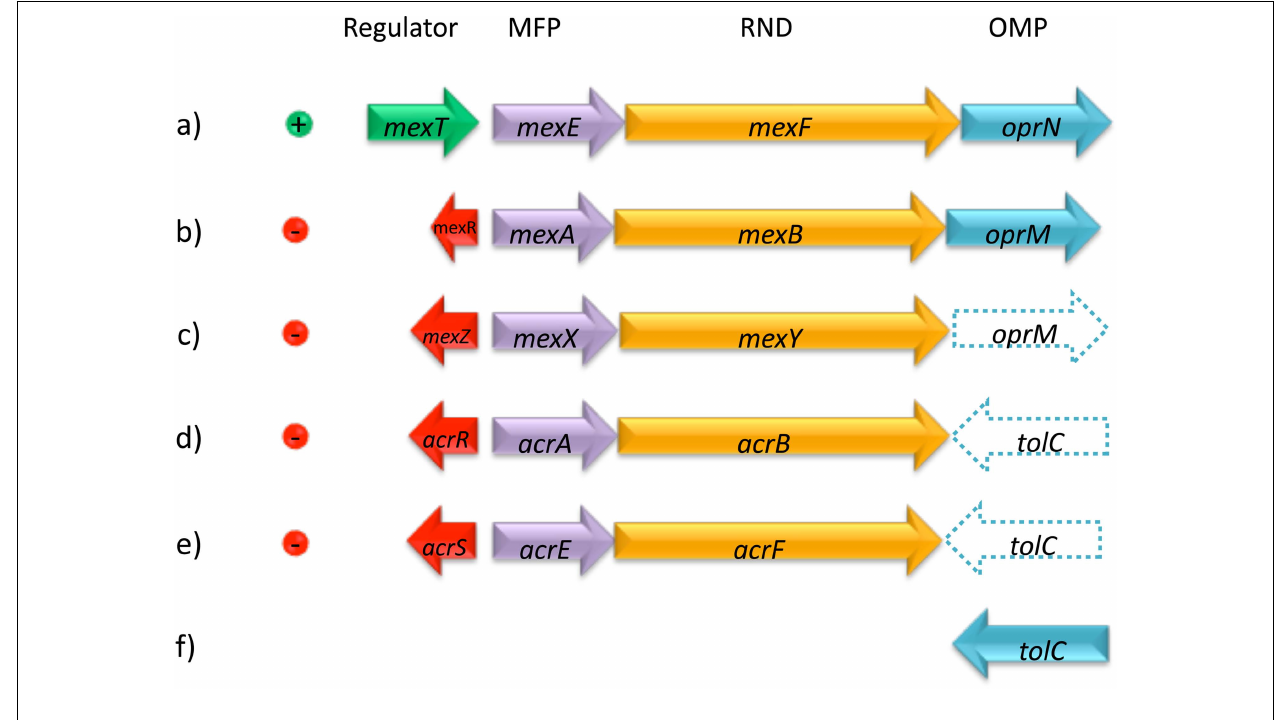
may use the OMP from another system, such as in the MexXY system using OprM (c).The OMP component may be located elsewhere in the chromosome, such asTolC (f) and can be used by one or more different systems as in the case of AcrAB (d) and AcrEF (e). MexEF-OprN, MexAB-OprM, and MexXY belong to P. aeruginosa ; AcrAB and AcrEF belong to E. coli